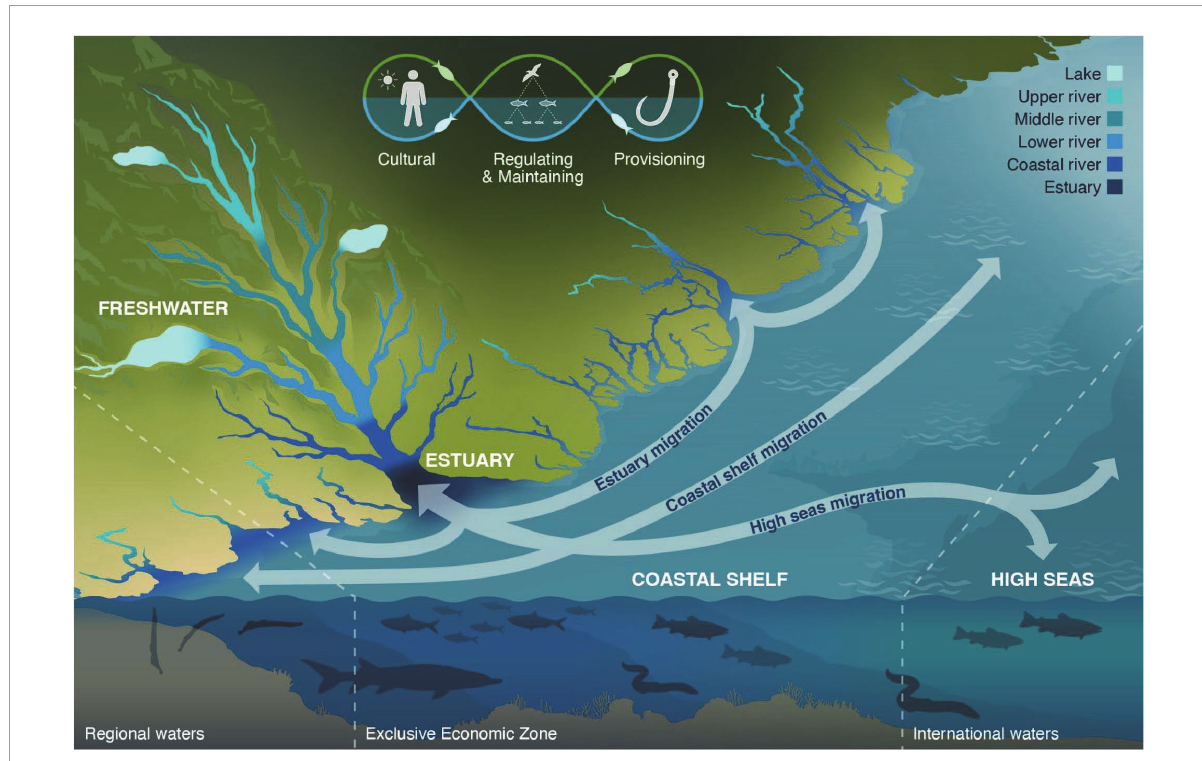
FIGURE5 Diadromous watershed-ocean continuum (DWOC) highlighting the various ecosystems that diadromous fishes connect through the delivery of ecosystem services (cultural, regulation and maintaining, and provisioning), from lakes and upper river areas to coastal and high sea areas, across regional and international borders. The ecosystem services logo highlights how these services are connected through the diadromous community and provide essential connections between ecosystems, which vary spatio-temporally via the migrations paths and habitats occupied by diadromous fishes along the watershed-ocean